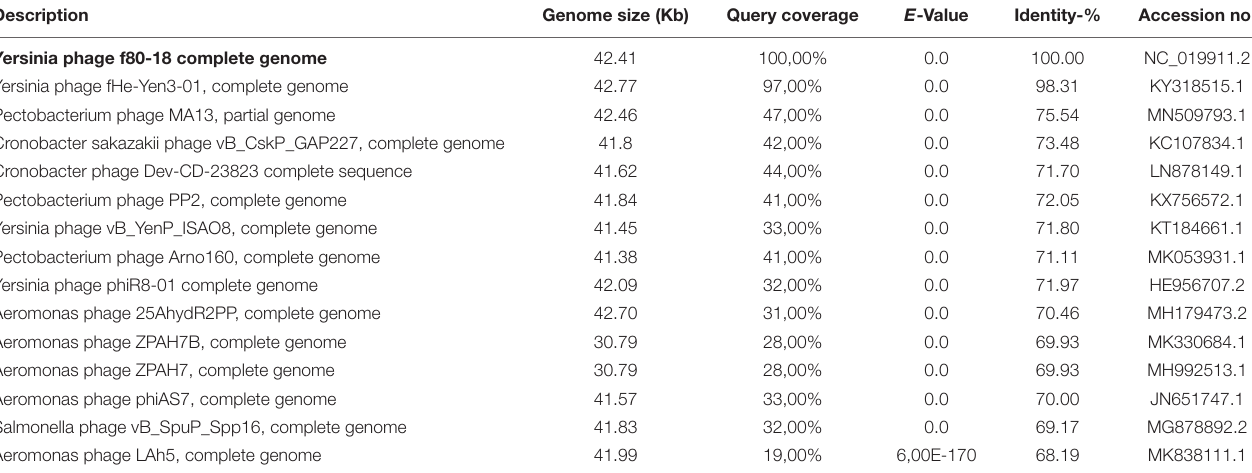
TABLE 1 | Overview of 15 phages most closely related to phage φ